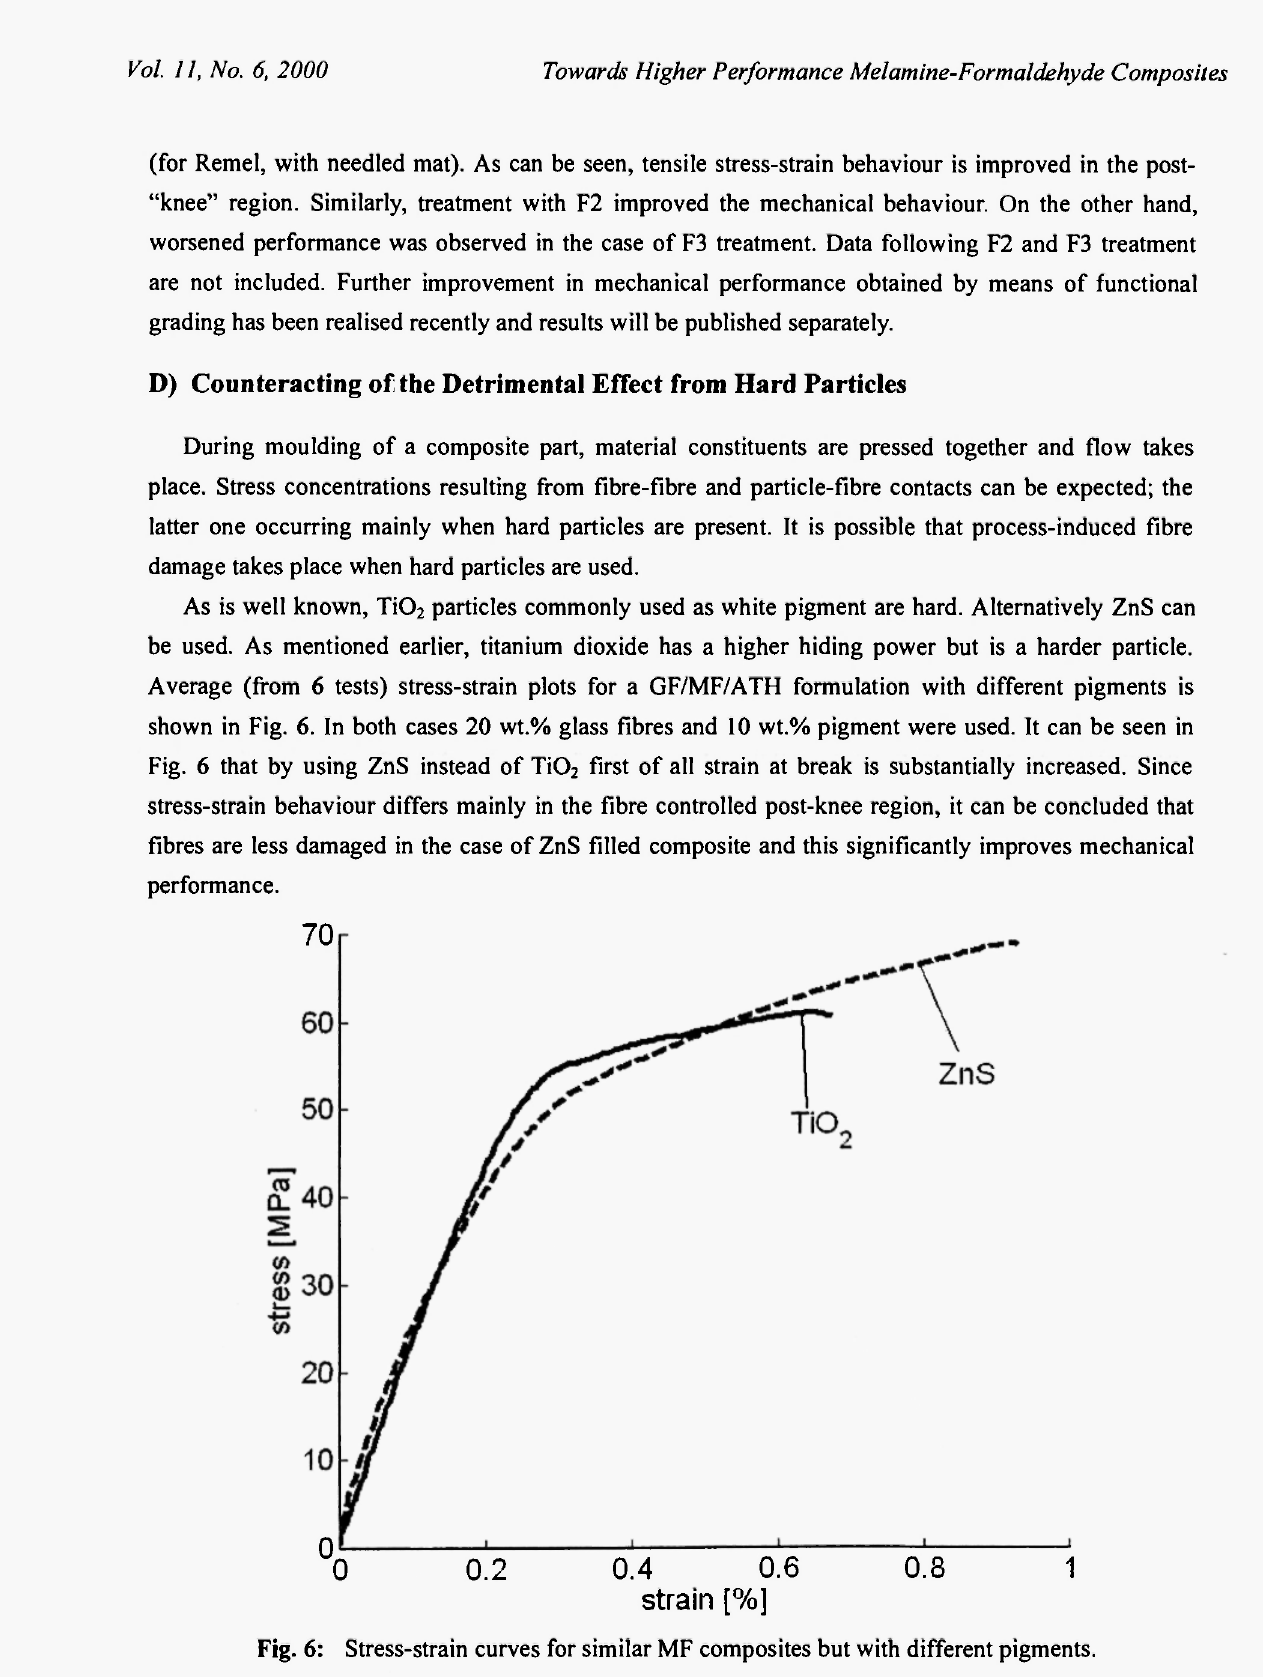
Fig. 6: Stress-strain curves for similar MF composites but with different